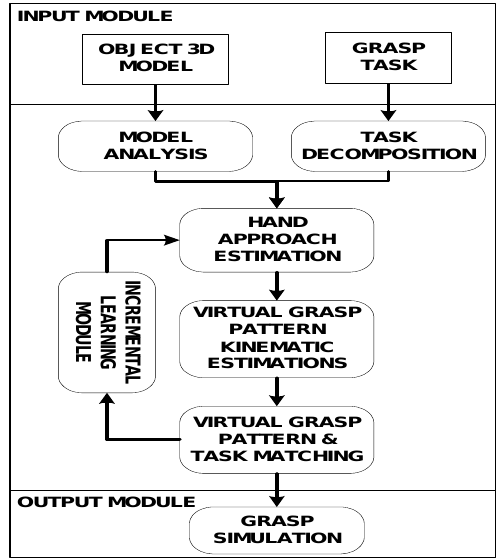
Figure 1. Preshape Estimation Methodology